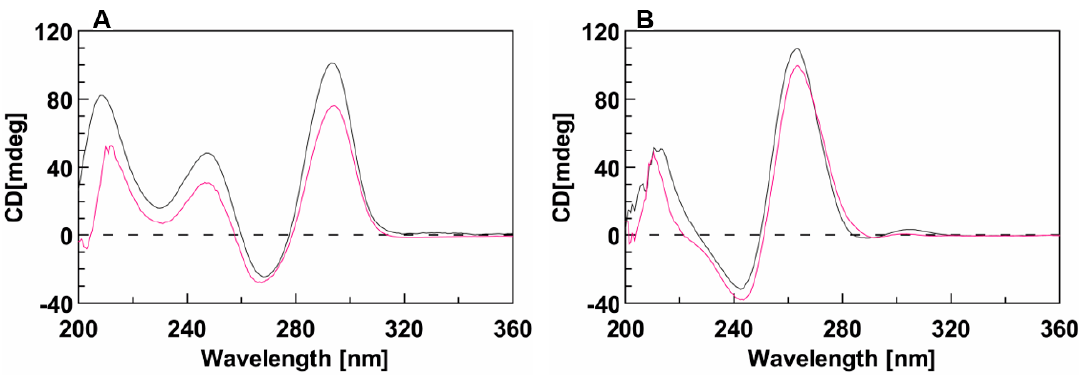
Figure 3. CD spectra of ( A ) TBA (black line) and 5 ′ -DMAzo-TBA (fuchsia line), acquired in 100 K buffer (pH = 7.4) and of ( B ) T30695 (black line) and 5 ′ -DMAzo-T30695 (fuchsia line), acquired in 10 K buffer (pH = 7.4). T = 10 °C; [ON] = 20 µM. Cuvette o.l. 1.0 cm, Vol = 1400 µL.